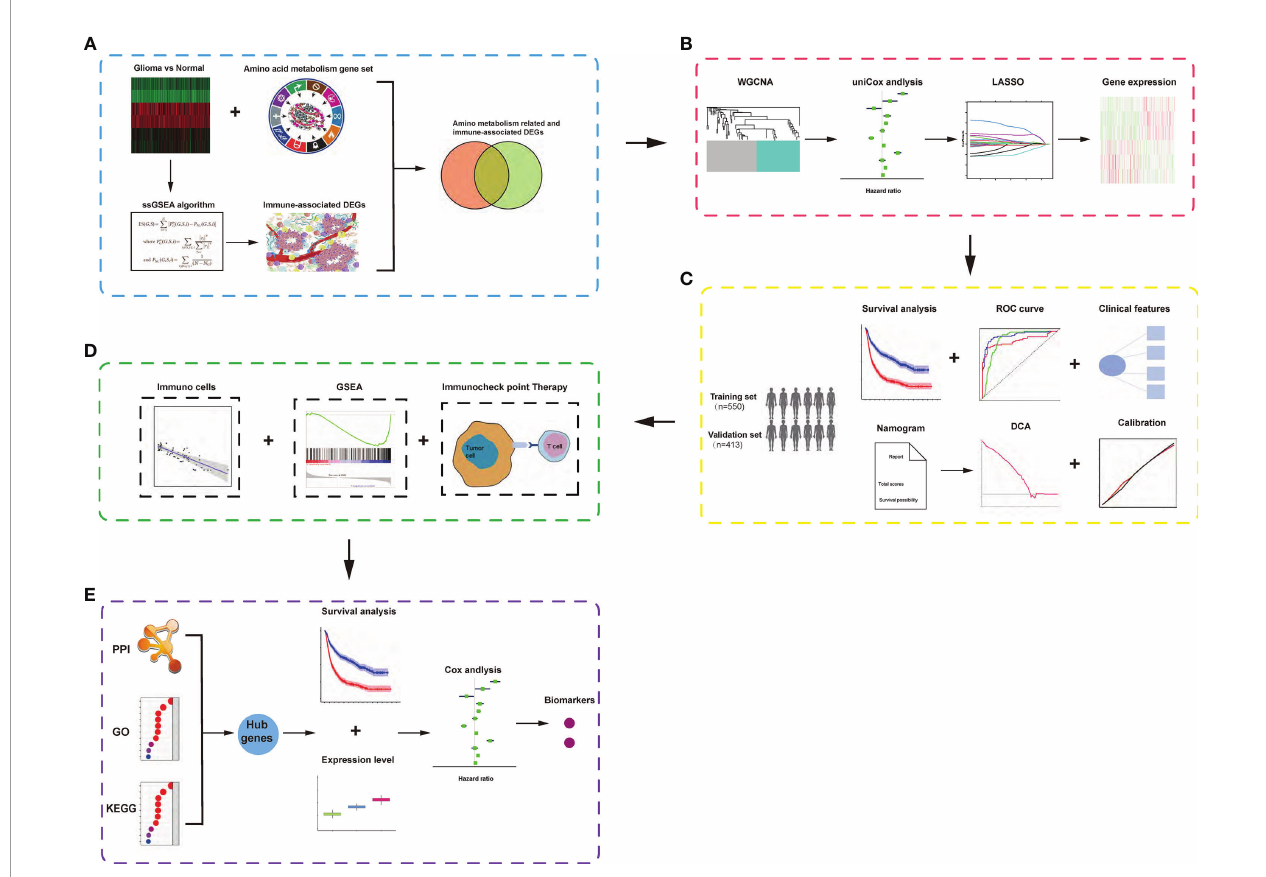
FIGURE 1 | Schematic diagram of the study design. (A) Identi fi cation of amino acid metabolism-related and immune-associated gene module in glioma patients among various hallmarks of cancer. (B) WGCNA and least absolute shrinkage and selection operator Cox algorithms were combined to develop an amino acid metabolism-related and immune-associated gene signature for prognosis. (C) The prognostic and predictive capacities were validated in different cohorts and methods. (D) Comprehensive analyses of enriched pathways, immune cell in fi ltration, and therapeutic responses in different risk groups. (E) Identi fi cation of hub genes and biomarkers from gene signature for